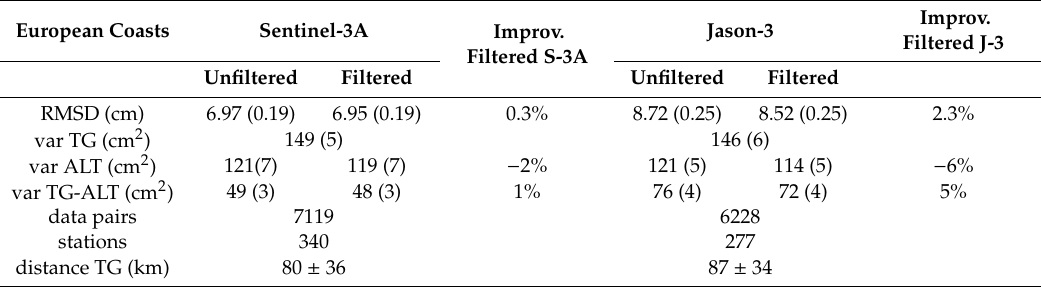
Table 3. The same as Table 1 but for the inter-comparison using Lanczos low-pass filtered SLA and SLA measurements without filtering for the Sentinel-3A and Jason-3 satellite missions. Common tide gauge stations for each satellite mission have been